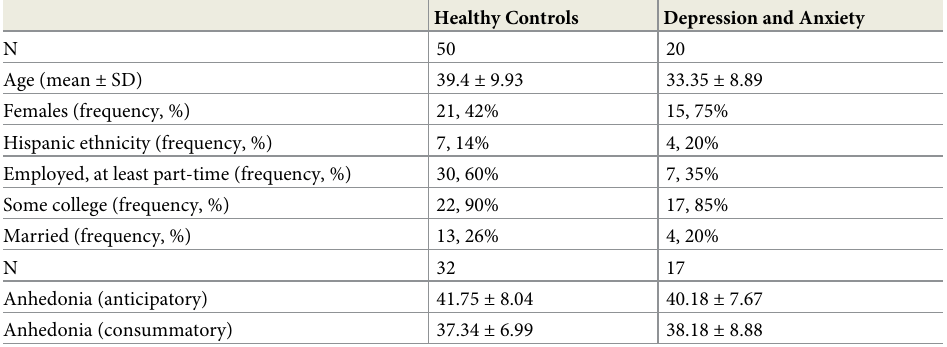
Table 1. Participant characteristics for Experiment